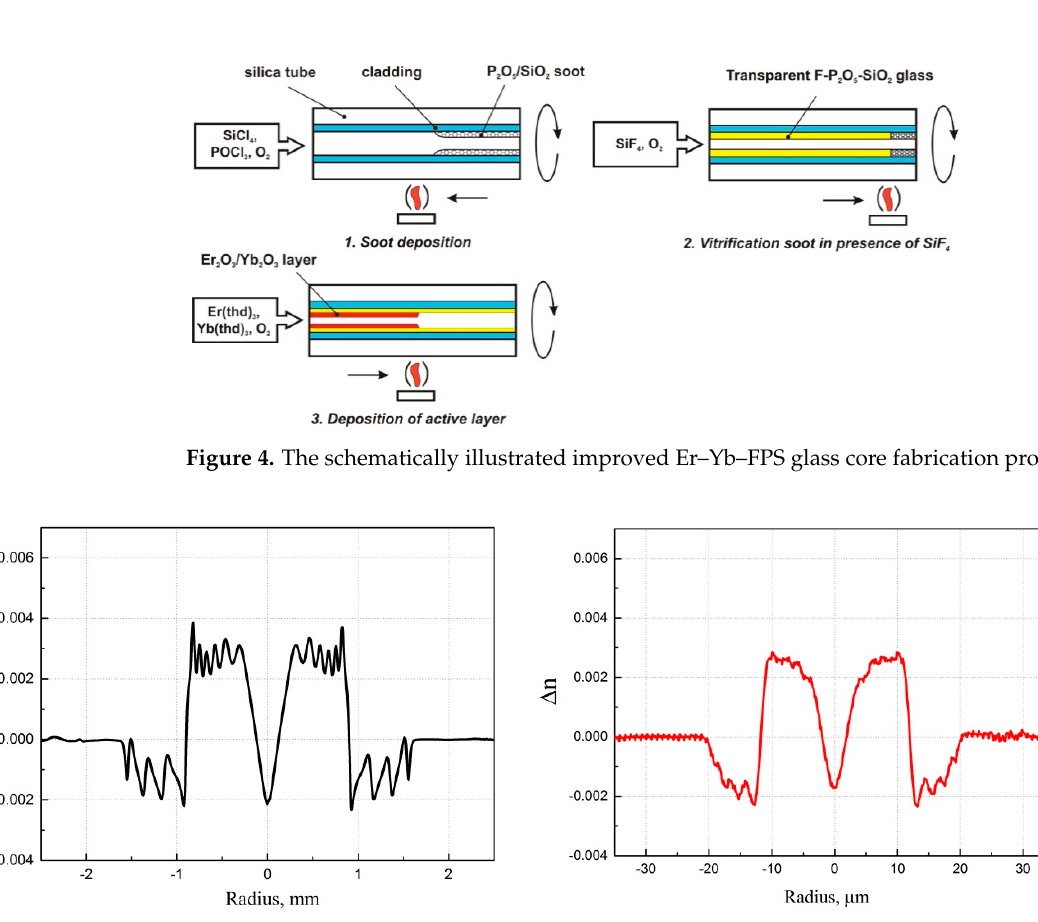
Figure 4. The schematically illustrated improved Er–Yb–FPS glass core fabrication process.